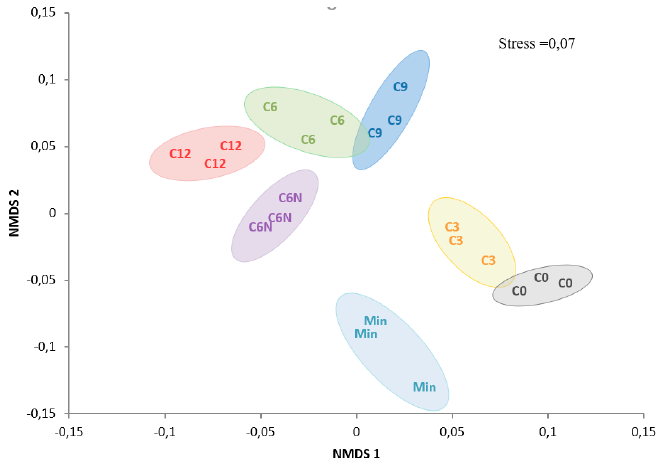
Figure 6. Beta-diversity of the bacterial community evaluated by non-metric multidimensional scaling (NMDS). C0, unfertilized soil; C3, C6, C9 and C12 = 3, 6, 9 and 12 Mg/ha sewage sludge compost, respectively; C6N, combined application of 6 Mg/ha of sewage sludge and 60 kg/ha N; Min, mineral fertilization.